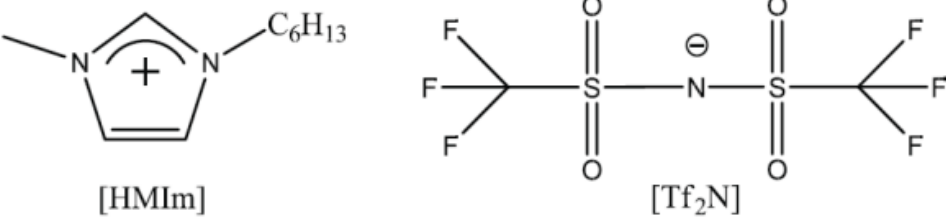
Figure 2. Molecular structure of the considered ionic liquid [hmim][Tf 2 N] [37]. Table 2. Elemental chemical analysis of [hmim] [Tf 2 N] ionic liquid according to the IUPAC [55]. C.%